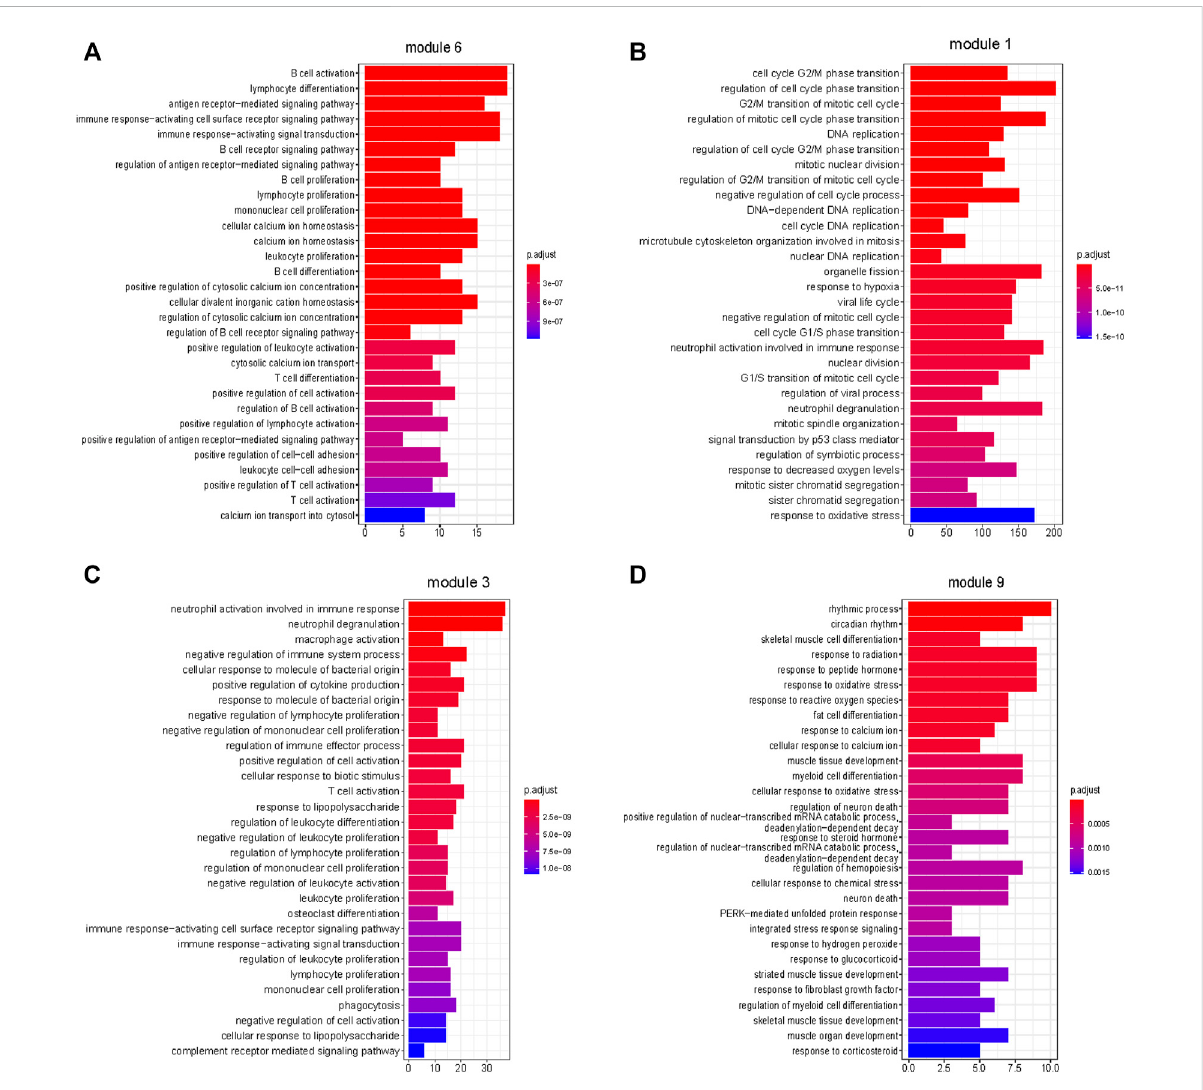
FIGURE 5 Enrichment of biological pathways in modules. (A – D) The top 30 pathways that enriched in module 6, module 1, module 3, and module 9, respectively. (A,C) Immune-related processes wereenriched inmodules 6and 3. (B) Cellproliferation-related processes wereenriched inmodule1. (D) Cellular responses to external stimuli were enriched in module 9. (FDR <